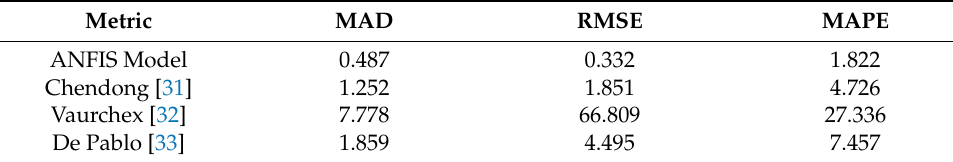
Table 4. Appraisal Criterion of Proposed ANFIS LOL